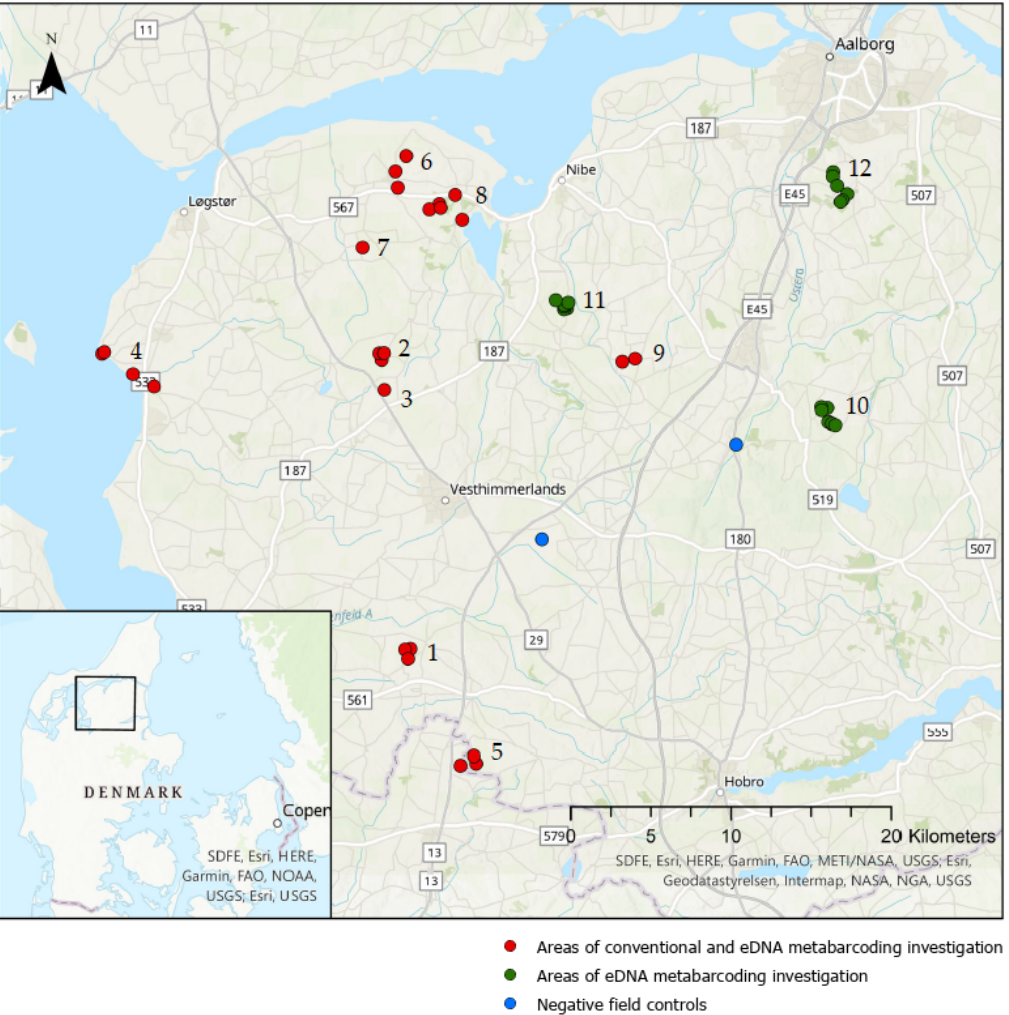
Figure 1. Overview of all investigated areas in Himmerland, Denmark. Red dots show areas where both eDNA metabarcoding and conventional survey methods were applied. Green dots show areas where eDNA metabarcoding was exclusively applied. Blue dots show areas of negative field controls for the eDNA metabarcoding survey. Numbers indicate an investigation area consisting of one to eight sites. Each dot represents a lake or